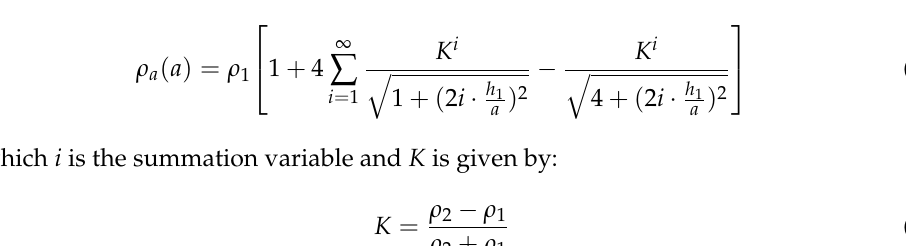
Figure 2 indicates the measurement/stratification location.